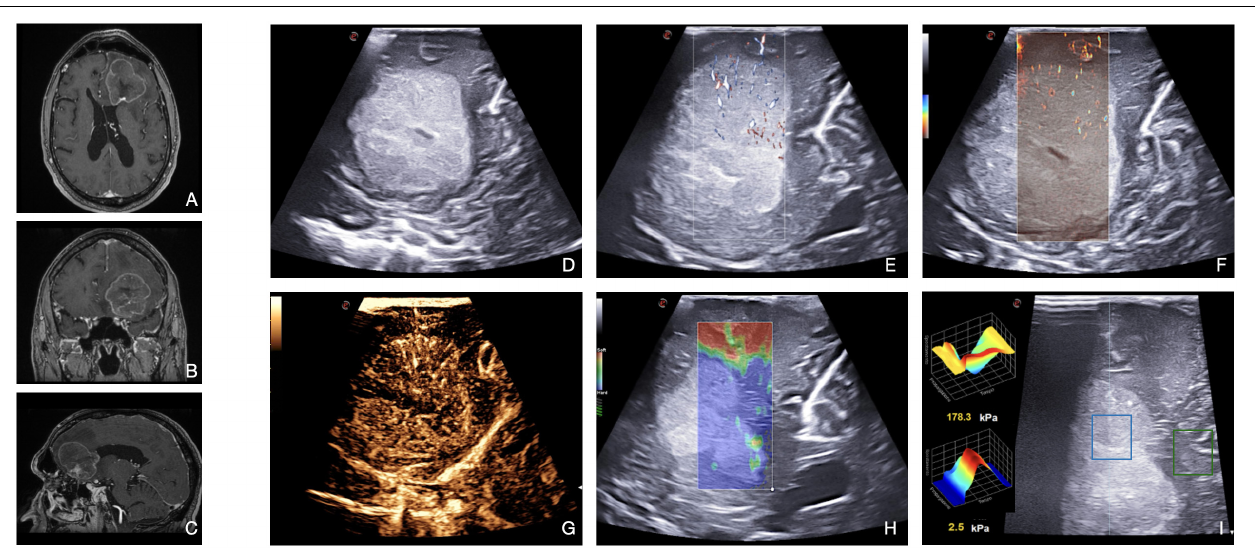
FIGURE 8 | Illustrative case of brain metastasis of lung carcinoma. (A–C) Pre-operative MRI demonstrates a left frontal, enhancing, intra-axial tumor. (D) B-mode: the lesion appears distinctly hyperechoic with a diffuse granular and heterogeneous aspect. The central core is necrotic. Tumor/brain interface is recognizable. (E,F) Micro-Doppler techniques (X-Flow and micro-V) demonstrate the presence of intratumoral microvascularization, thus informing on perfusion pattern. (G) CEUS shows a moderate and heterogeneous contrast enhancement pattern with centripetal dynamics. The central necrotic core is highlighted. In general, metastasis may appear as stiffer or milder than a healthy brain. In this case, (H,I) SE shows a high stiffness (blue) in the neoplastic region analyzed, while SWE quantifies the stiffness in specific ROI (the central blue ROI has a stiffness of 2.5 kPa, while the peripheral green ROI of 178.3